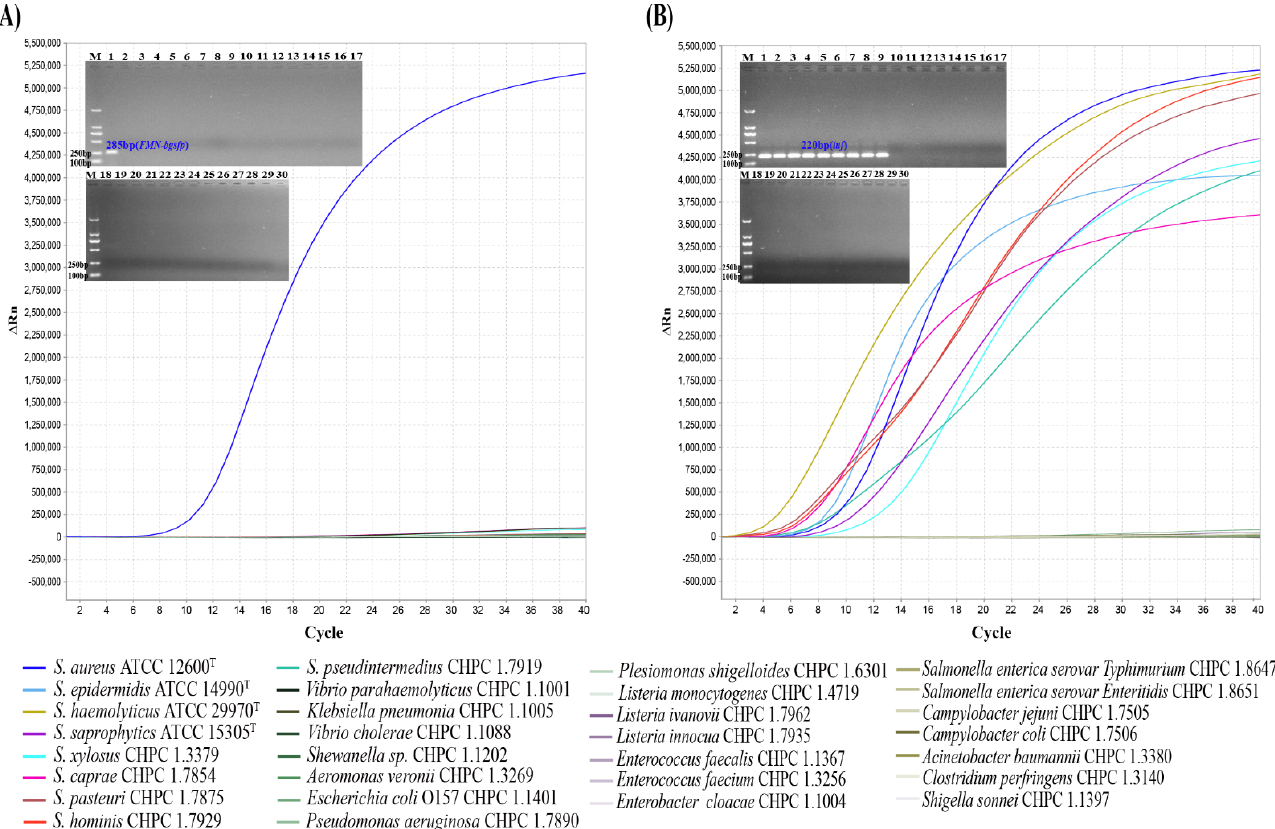
Figure 2. The amplification curves and the results of agarose gel electrophoresis of singular MIRA- qPCR and singular conventional PCR. ( A ) Detection of S. aureus species-specific gene FMN-bgsfp . ( B ) Detection of Staphylococcus genus-specific gene tuf. Insets show the results of conventional PCR.